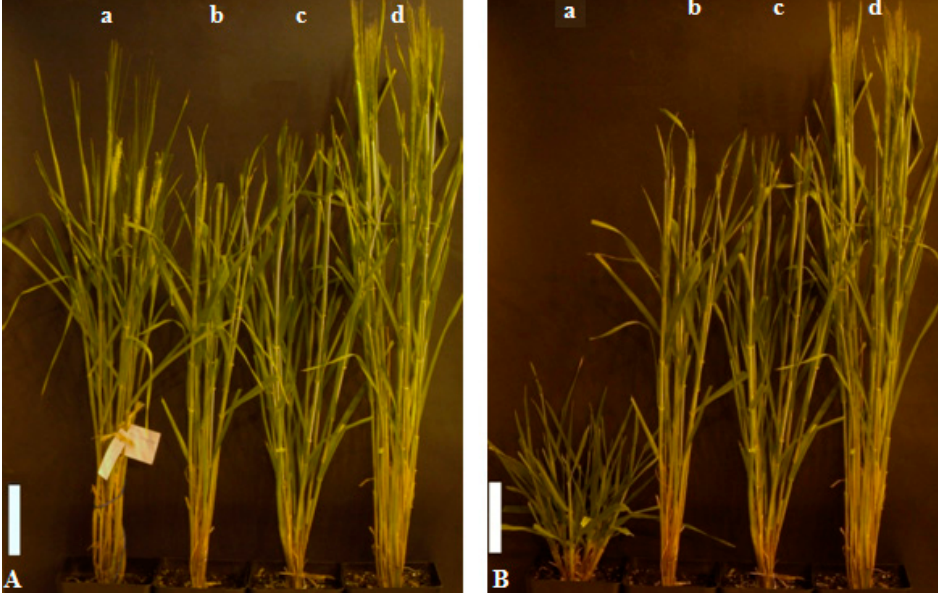
Figure 5. Phenotypes of the homozygous brd1-a , brd1-b , brd1-c and brd1-d mutant plants and the “Sebastian” variety: ( A ) brd1-c ( a ), brd1-b ( b ), brd1-a ( c ) and “Sebastian” ( d ); and ( B ) brd1-d ( a ), brd1-b ( b ), brd1-a ( c ) and “Sebastian” ( d ). Plants of all the genotypes are presented at the same developmental stage. Bar—10 cm.